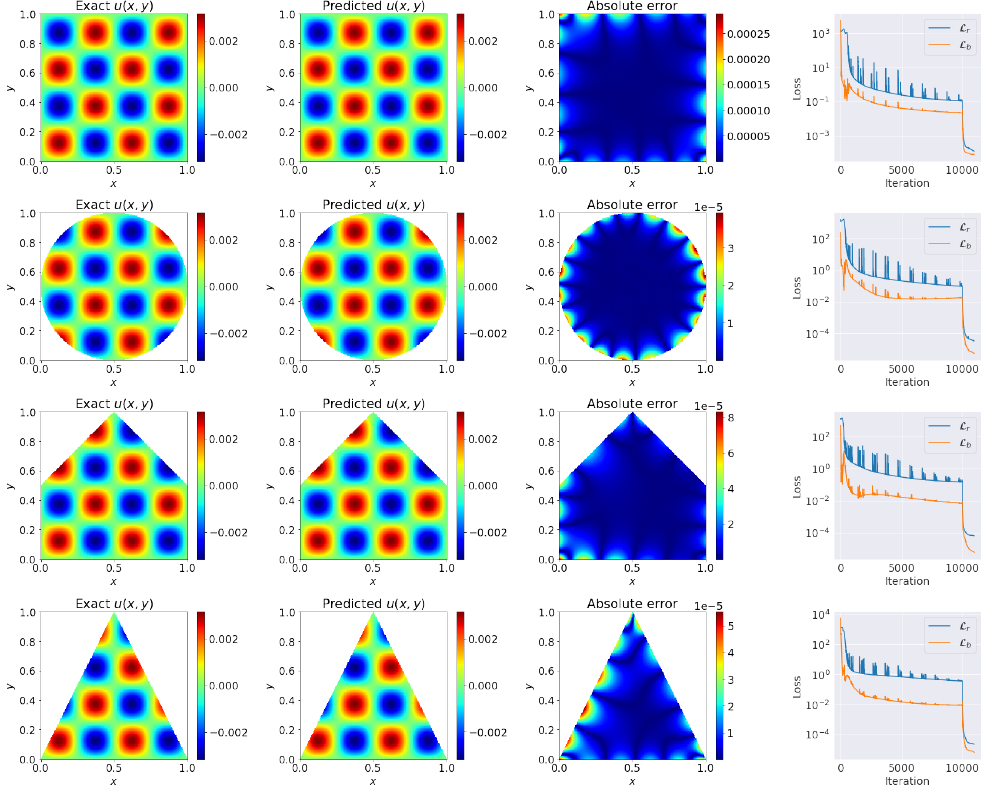
Figure 8. cSPINNs results (with ResNet block-enhanced modified neural network) for solving the 2D Poisson equation with an exact solution u ( x , y )